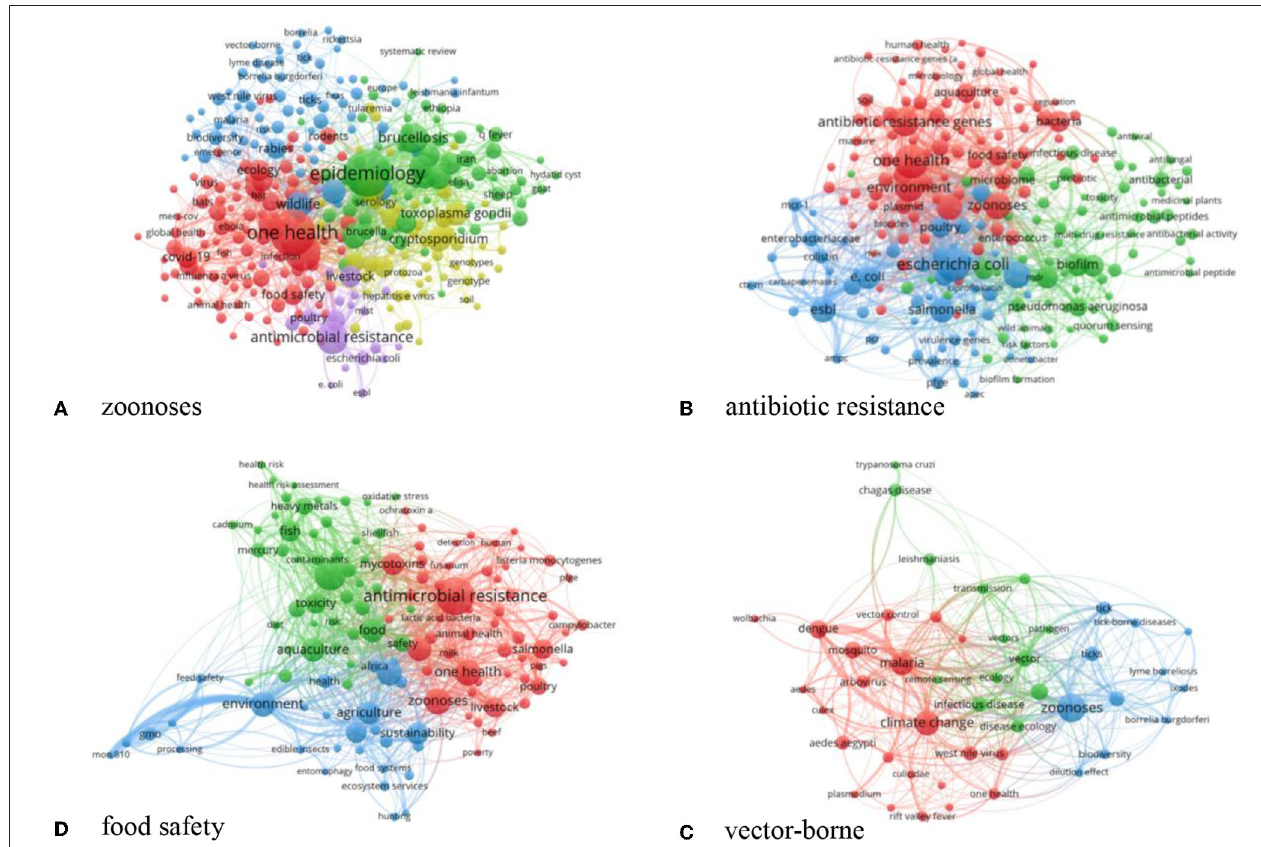
FIGURE 5 | Co-occurrence clustering map of keywords on the four priority topics of One Health,